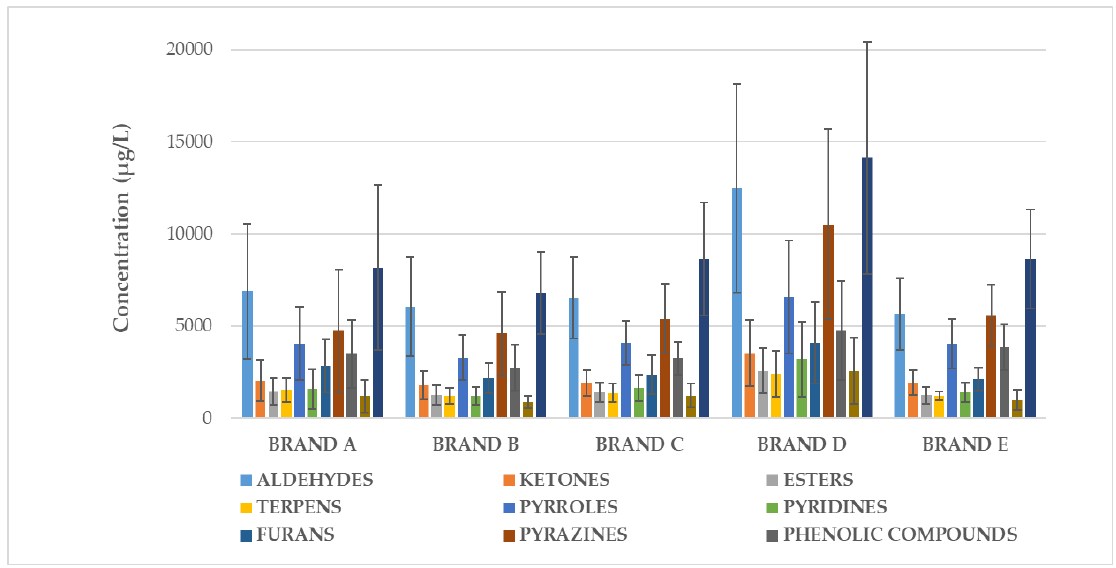
Figure 1. Mean total sum of volatile compounds (µg/L) determined on EC samples from each brand divided by chemical classes. Bars refers to inter-brand variability.